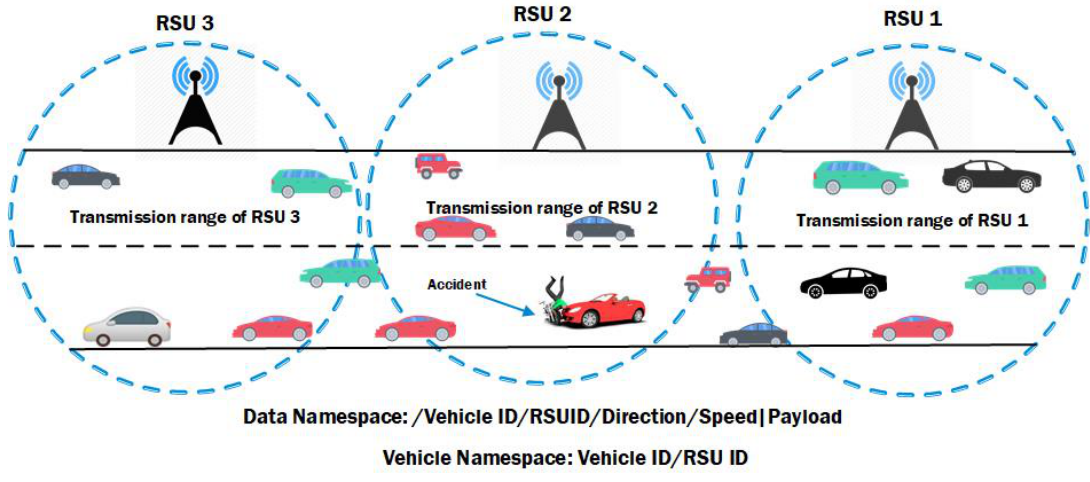
Figure 5. Vehicular Named Data Networks